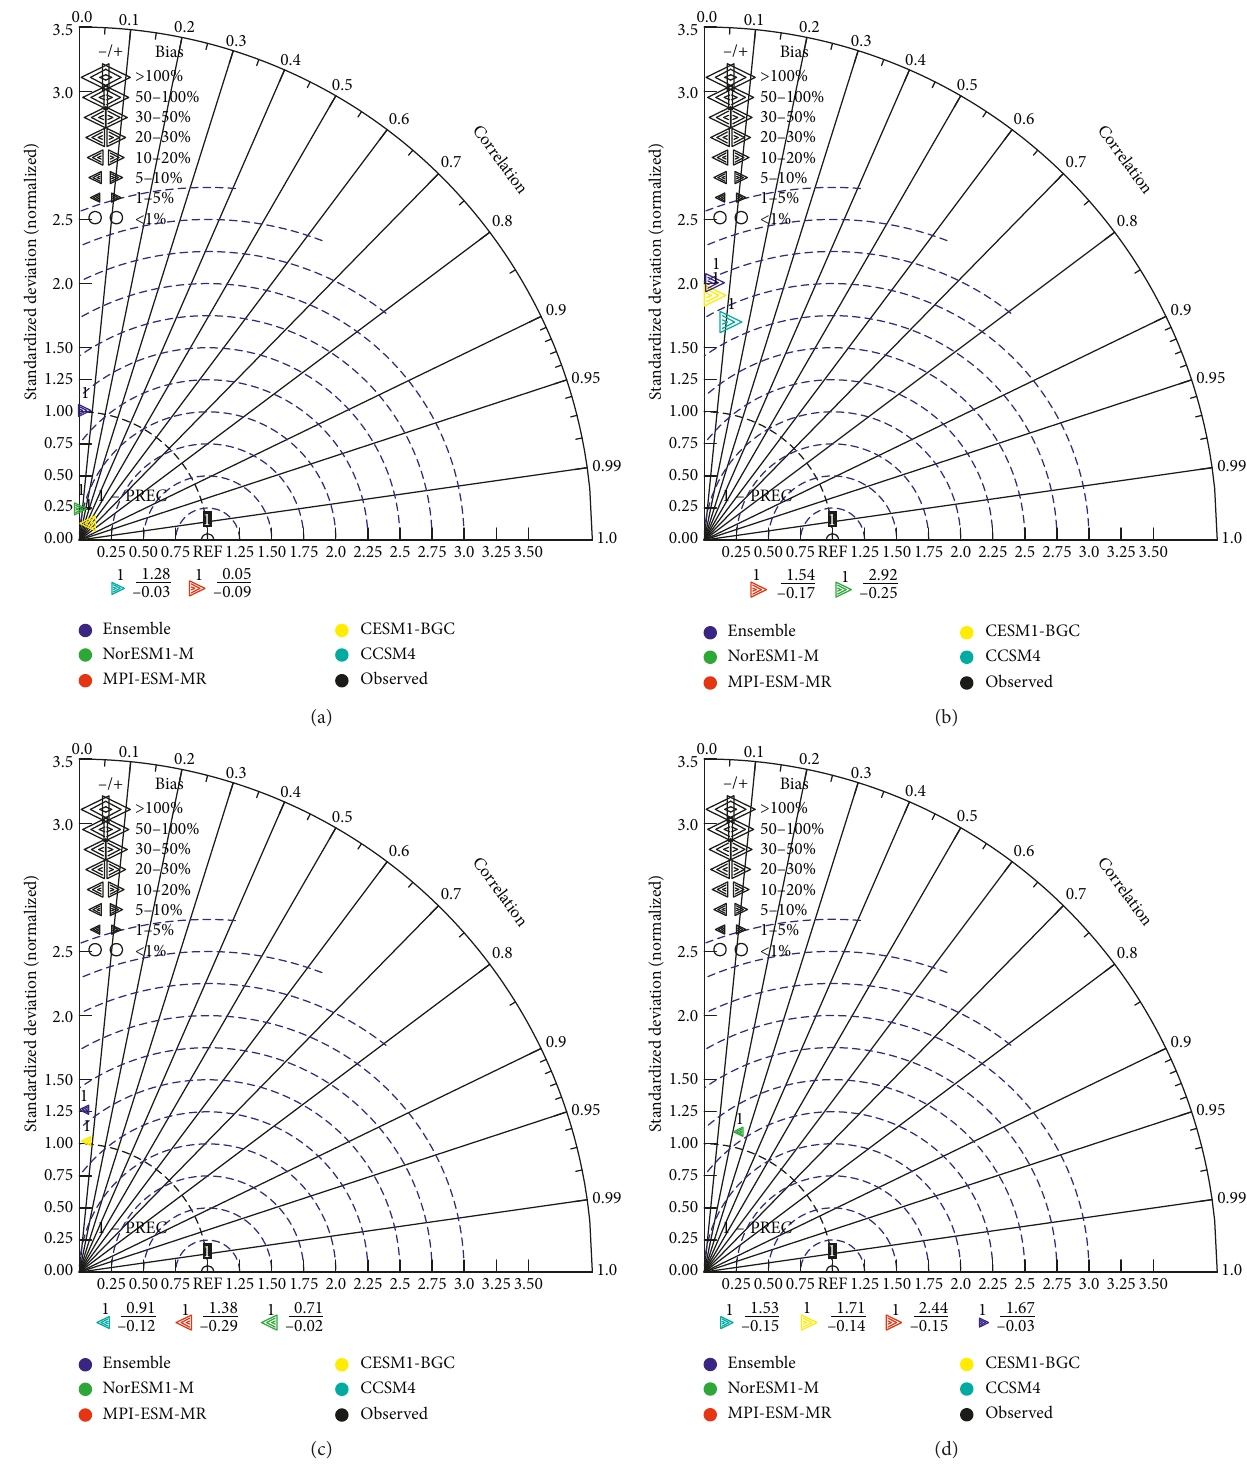
Figure 12: Taylor diagram for the Sahel showing the normalized standard deviation, the correlation, and the RMSE representing the variability, pattern, and errors, respectively, within the models and the reference data: DJF (a); MAM (b); JJA (c); SON